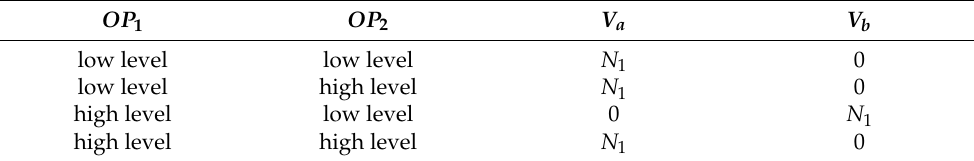
Table 2. The voltage of a , b .